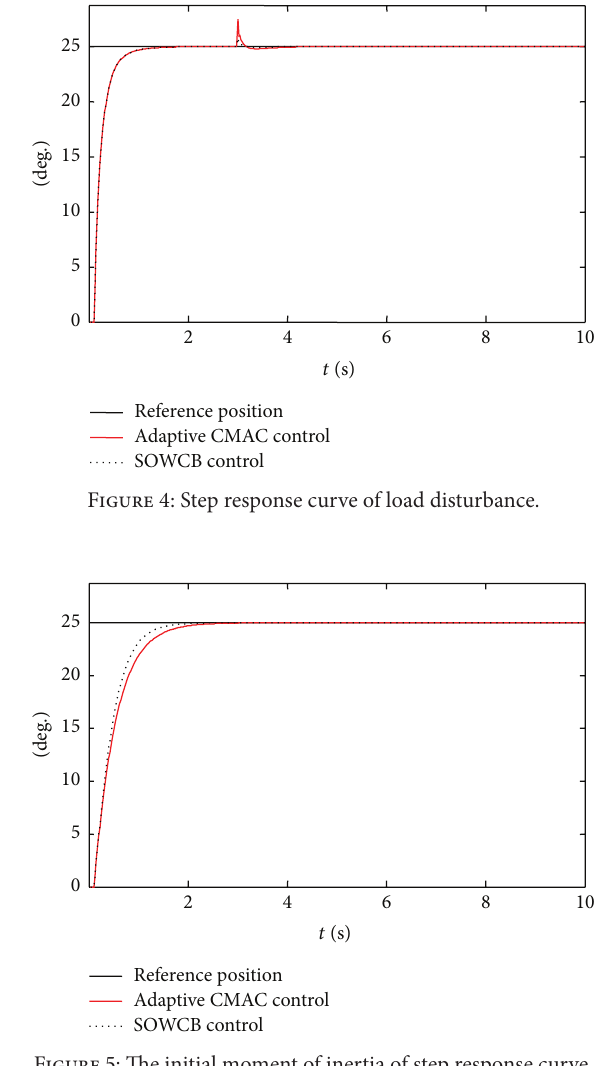
Figure 5: The initial moment of inertia of step response curve. Figure 7: Tracking error curve of the system. friction moment of the load: 850 kg ⋅ m 2 ; reduction ratio: 𝑖 = = 0.195 N ⋅ m/A; and choose 1002 ; motor torque coefficient 𝐾 𝑡 initial node 𝑛 𝑏 = 1 . The initial parameter is set to the wavelet function: 𝑎 𝑖1 = 0 , 𝑏 𝑖1 = 1.2 . Select input layer in wavelet CMAC 𝑛 𝑎 = 2 ; self-organizing wavelet CMAC adaptive backstepping controller parameter selection for 𝜂 1 = 0.5 , = 0.1 , 𝜂 = 0.1 , 𝜌 = 0.2 , 𝑐 = 0.3 , 𝑚 = 0.5 , 𝛽 = 0.01 , 𝜂 2 3 1 th th and 𝜏 = 0.01 .